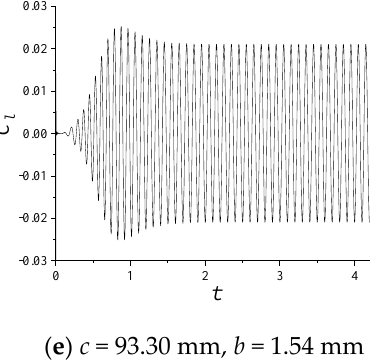
Figure 13. Variation of the lift coe ffi cient C l with respect to the trailing-edge thickness, b